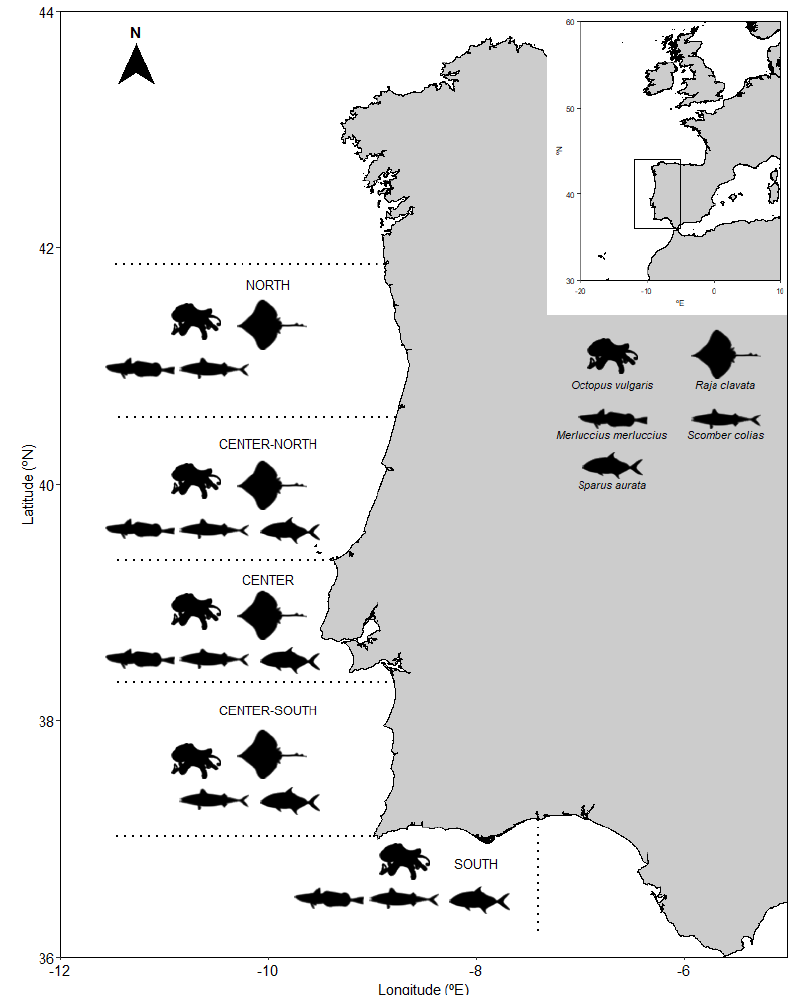
Figure 1. Merluccius merluccius, Octopus vulgaris, Raja clavata, Sparus aurata, and Scomber colias sampling sites along the Portuguese Atlantic coast.